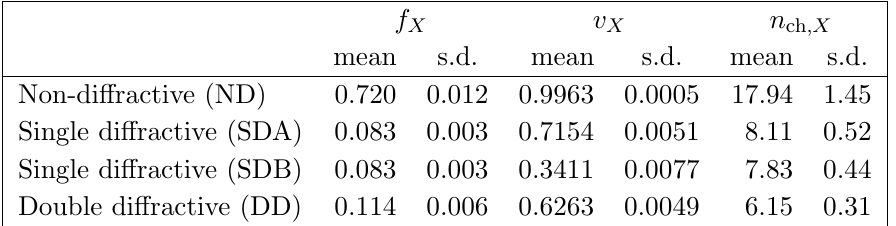
Table 2 . Properties of Pythia 8.230 proton-proton tunes. Mean values and standard deviations are given for the fractions f X of the inelastic cross-section, the fractions v X of interactions inside the acceptance and, for those interactions, the average numbers of long-lived prompt charged particles n ch ;X inside the